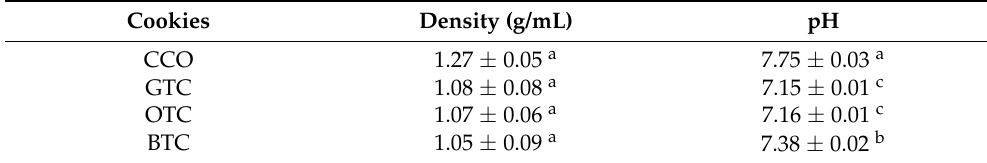
Table 3. The density and pH of the dough of non-gluten shortbread cookies with various spent tea leaf